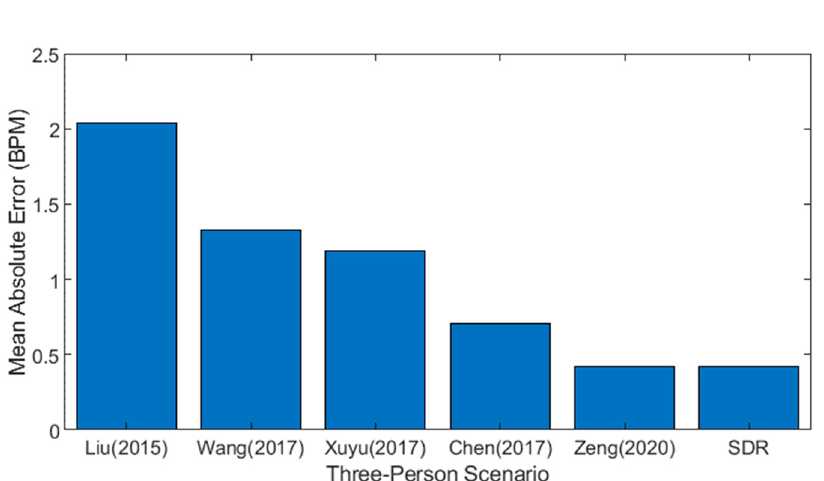
Figure 13. Comparison with previous approaches [34,36,38,39,49].